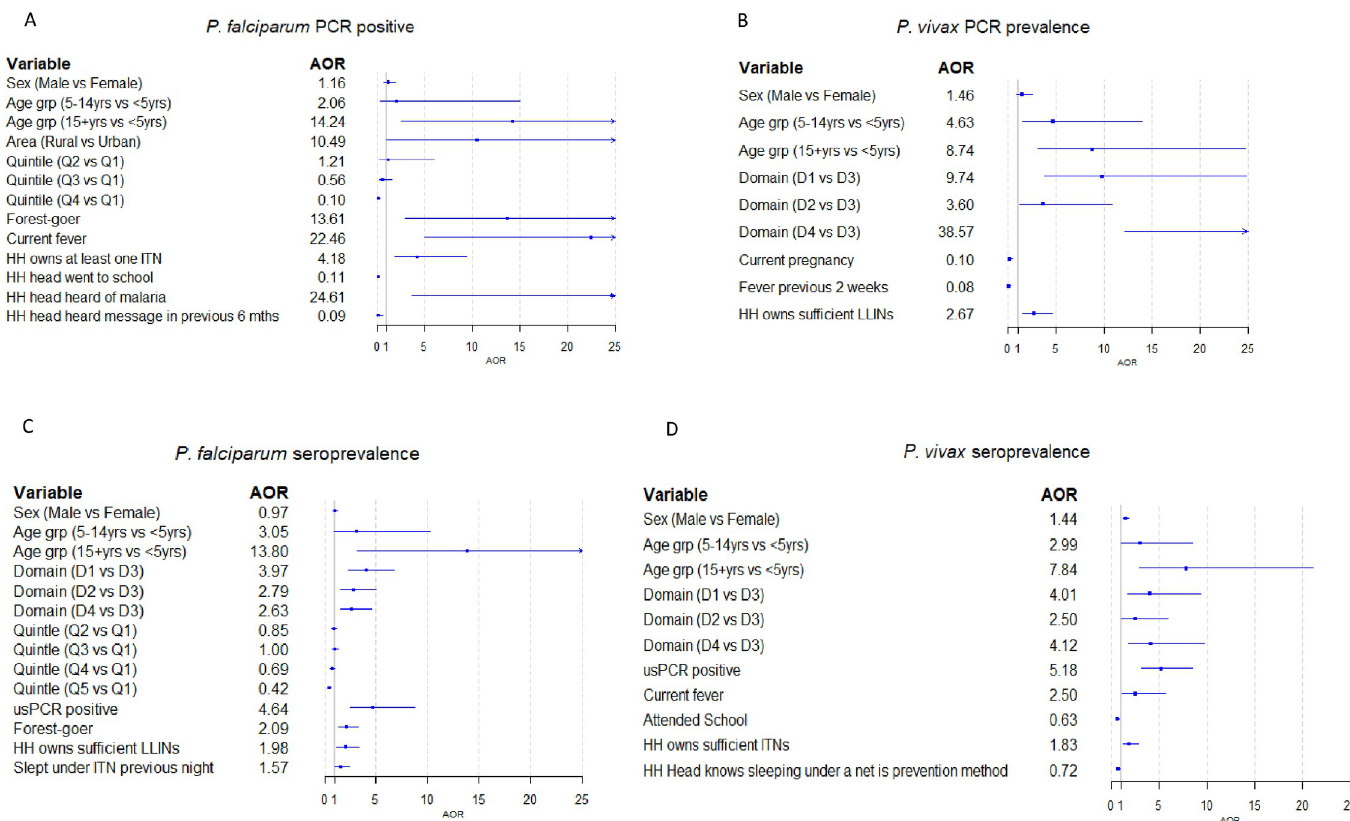
Fig 5. Forest plots showing Adjusted Odds Ratios (AOR) for risk factors related to being positive by usPCR or by serology across the whole study sample (n = 13,716 for PCR and 11,653 for serology). A] Prevalence of P . falciparum , B] PCR prevalence of P . vivax , C] Seroprevalence of P . falciparum , D] Seroprevalence of P . vivax . Factors shown are those that remained significant in multivariate logistic regression analyses (plus sex and age group).